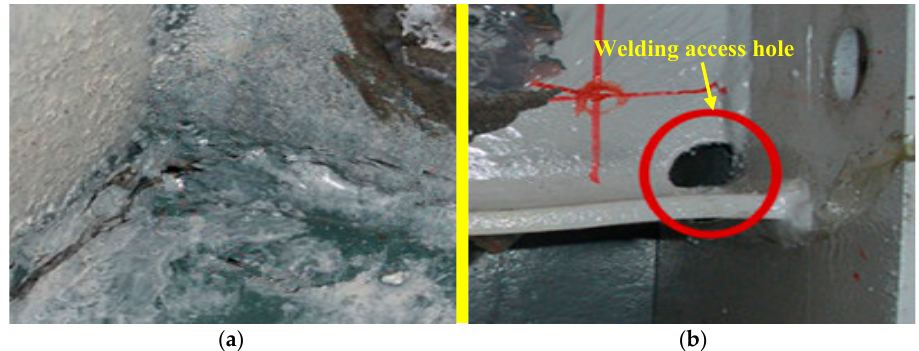
Figure 2. Welding access hole treatment. ( a ) L1, L2, and L6; ( b ) L3, L4, L5, L7, and L8.